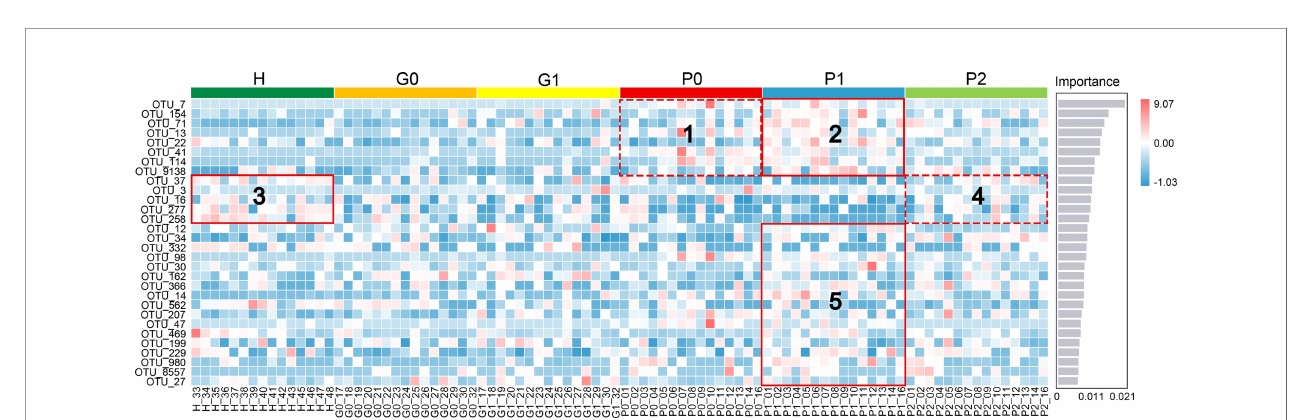
FIGURE 4 | Random forest classi fi cation model for different periodontal statuses based on free salivary bacteria. The top 30 OTUs with the highest importance for classi fi cation are ranked on the left (see Appendix Table 3 for the complete list of taxa), and the score of importance is shown on the right. Different colors on the top identify the six sample groups. The heat map shows the abundance distribution of these taxa in each sample. Boxes 1, 2, and 5 were characterized by high levels of disease-associated taxa. Boxes 3 and 4 were characterized by health-associated taxa and other bacteria considered to have low pathogenicity.